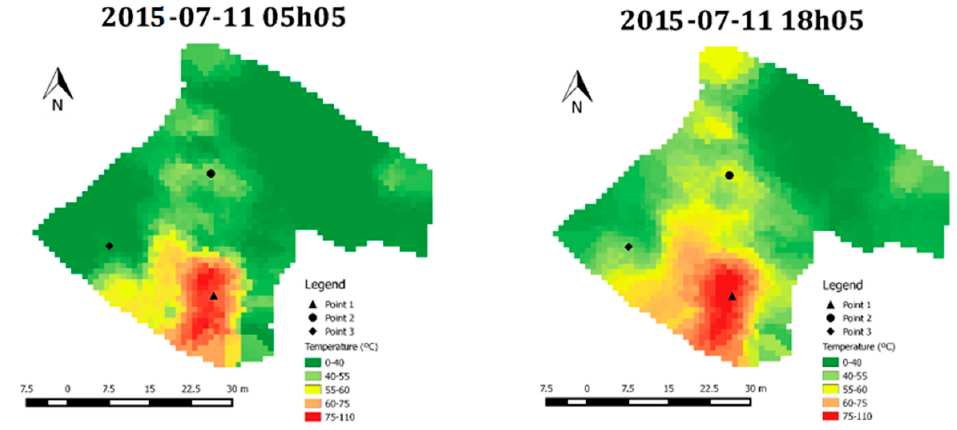
Figure 9. Temperature image map compositions for 11th July at 05h05 and 18h05.